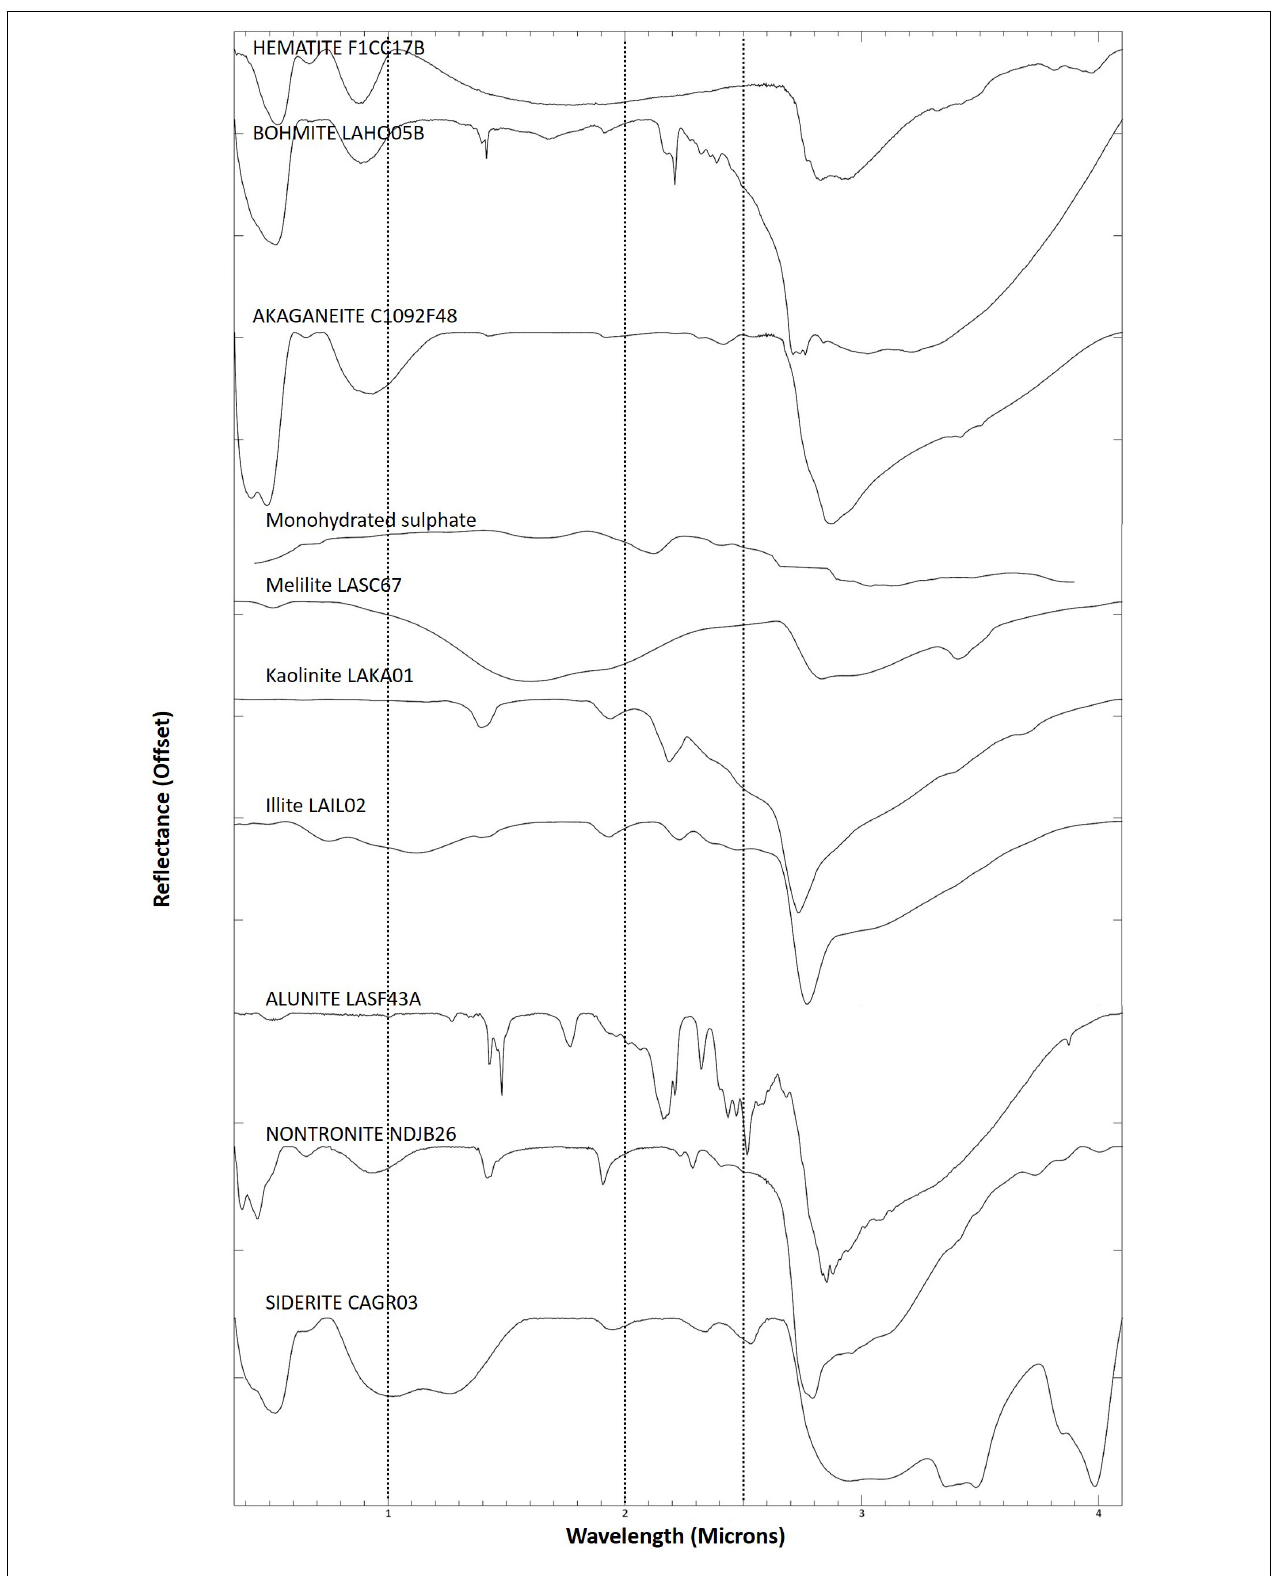
FIGURE 12 | CRISM laboratory end members downloaded from Grant et al. (2008) to match with extracted CRISM-ratioed spectra.